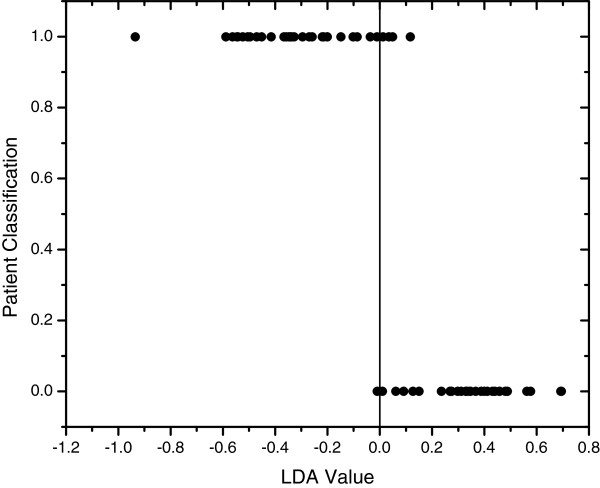
One dimensional SIR plot showing classification of dogs into groups based on CLPDP. The vertical line separates the two groups based on the measured multidimensional characteristic (i.e., CLPDP). A linear discriminant analysis (LDA) value generated for each dog ranks the individual within the group relative to the vertical line. Individual dogs are represented as dots. Group 2B hyperlipidemic Miniature Schnauzers are represented by the dots that are at the bottom of the graph. Their CLPDPs plot them all to the right of the vertical line, with the exception of one dog with mildly increased serum TAG concentration (97% of dogs classified correctly). Group 2A normolipemic Miniature Schnauzers are represented by the dots at the top of the graph are the Miniature Schnauzers. All but 2 of the Group 2A dogs are classified as a separate group to the left of the vertical line (94% of dogs classified correctly).